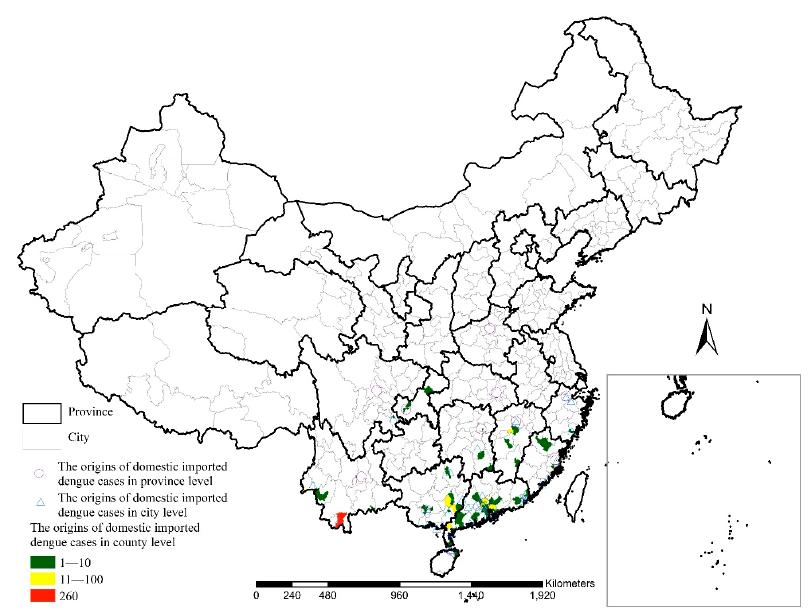
Figure 3. Origins of domestic imported dengue cases in mainland China in 2019.